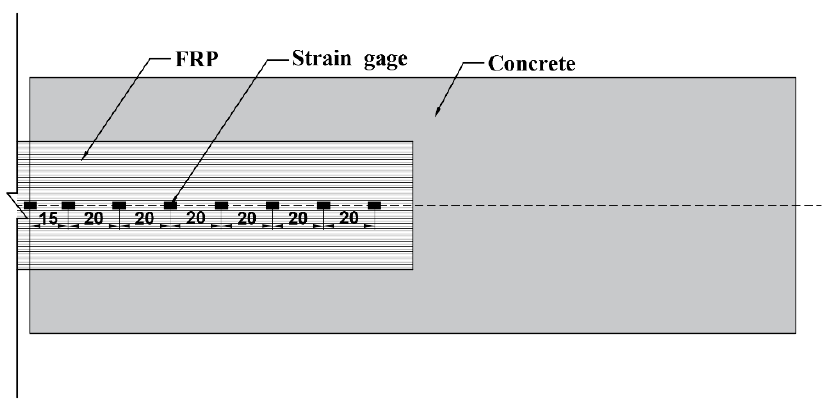
Figure 10. Location of the strain gauges.